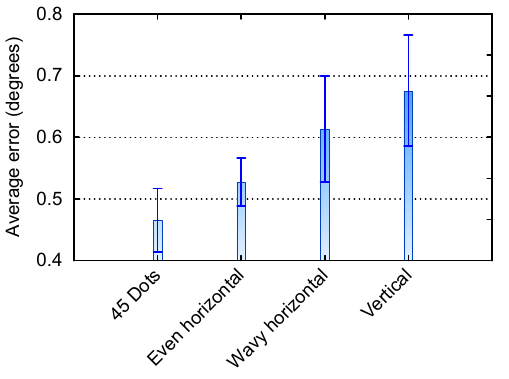
Figure 4. Average error over participants and val- idation targets for four calibration routines. The vertical bars denote the 95% confidence intervals of the means. A repeated measures analysis of variance (each partic- ipant calibrated with four different routines) showed that the calibration routine has a significant (α = .001) effect on the magnitude of the error (F(3,48) = 9.74, p < .000).